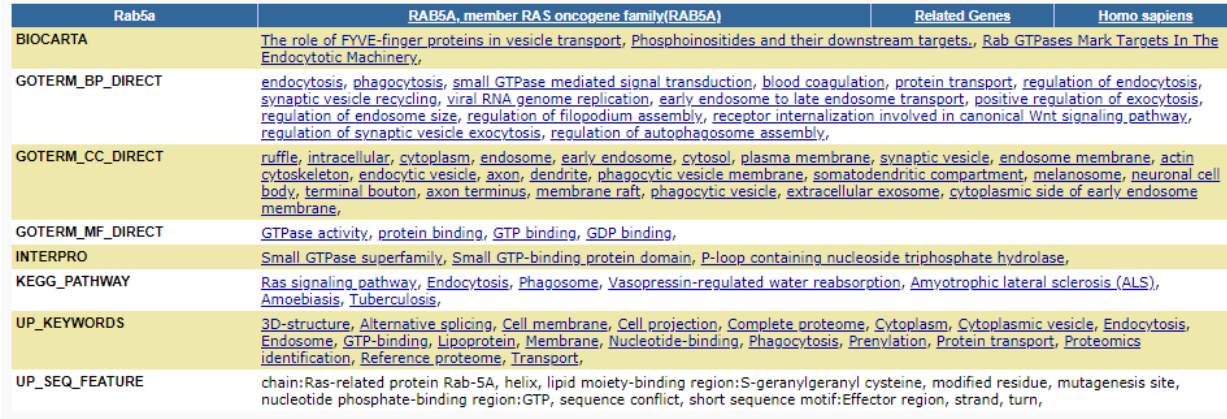
Figure 1. DAVID output for the RAB5A gene. Screenshot of the DAVID results for the RAB5A gene Top left (blue bar): Gene Symbol identifier. Center (blue bar): full gene name. Labels (left): GO Term BP, GO Term CC, and GO Term MF descriptors. Note that these descriptors are